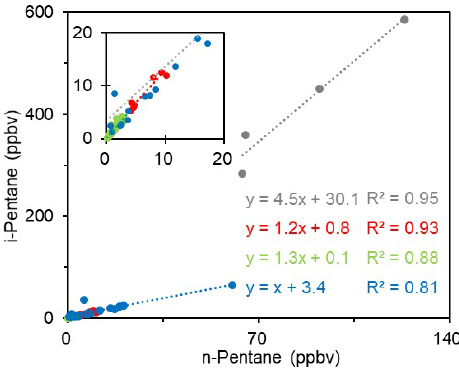
Figure 7. Scatter plot and regression lines of i -pentane versus n - pentane for the three types of ambient samples and oil field samples (grey: Type 1; red: Type 2; green: Type 3; blue: source; refer to the main text for the description of different types of data).